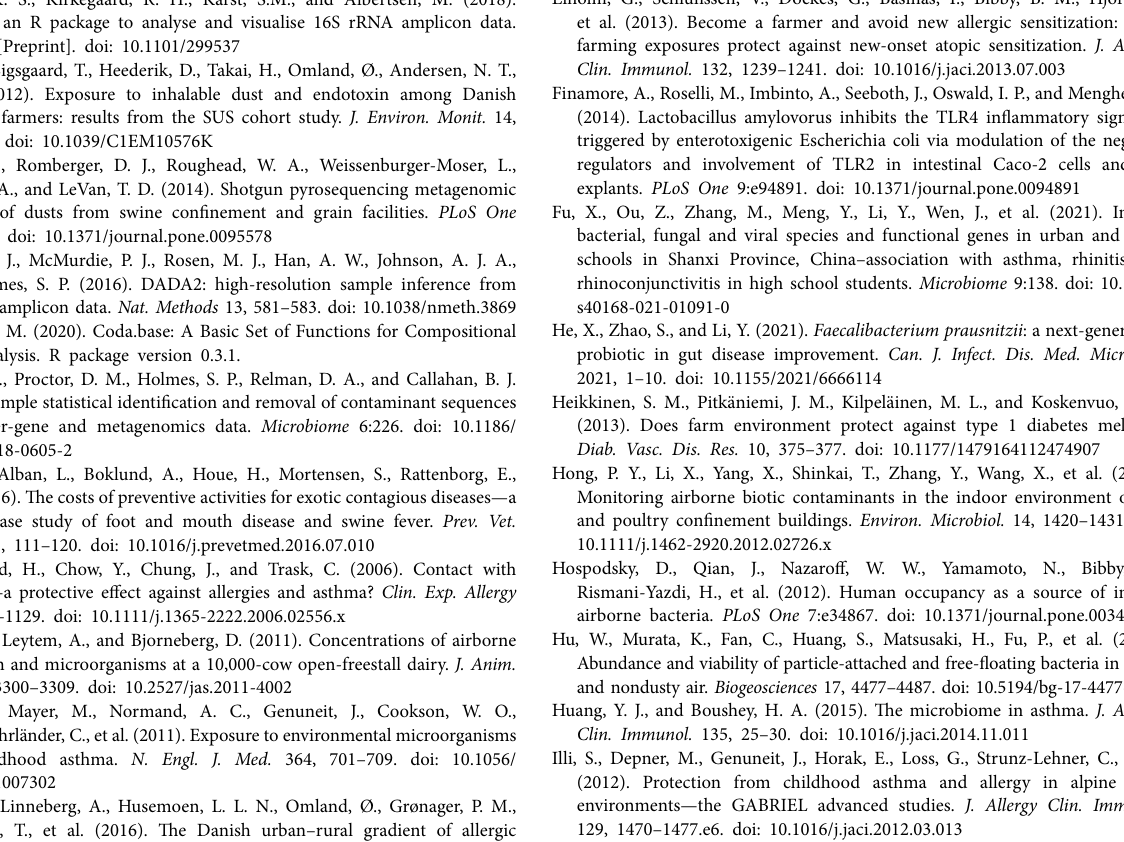
Supplementary Figure 2 | Principal coordinates analysis (PCoA) of microbial community structures of cow farmers’ homes and cow stables based on season using Aitchison dissimilarity matrix. On the right side ANOSIM R metric is used to infer the degree which the environment, where 1 means very different communities and zero means very similar communities. A significant difference (P < 0.05). Supplementary Figure 3 | Diversity measures of cow farmers’ homes and cow stables based on season. P values from Wilcoxon rank sum test comparing richness/Shannon index in different indoor environments. P values in bold are less than 0.05 indicate significant differences. (A) Violin plots richness in term of number of bacterial species (OTUs). (B) Violin plots of Shannon index considering both the richness and evenness. Supplementary Figure 4 | Plots showing the similarity rank of associated cow stable — cow farmers’ home pairs in a ranked list of all possible cow stable- home pairs. A similarity rank of 1 (Green bar) indicates that the airborne bacterial community in a given cow farmer's home is more similar to the cow stables where that farmer works than any other cow stable. Summer samples pairs showed 3 out of 12, while winter showed 6 out of 17 pairs were more similar than non-associated stable–home pairs. Supplementary Figure 5 | Plots showing the similarity rank of associated pig stable — pig farmers’ home pairs in a ranked list of all possible pig stable-home pairs. A similarity rank of 1 (Green bar) indicates that the airborne bacterial community in a given pig farmer's home is more similar to the pig stables where that farmer works than any other pig stable. Summer samples pairs showed 10 out of 40, while winter showed 4 out of 37 pairs were more similar than non- associated stable–home